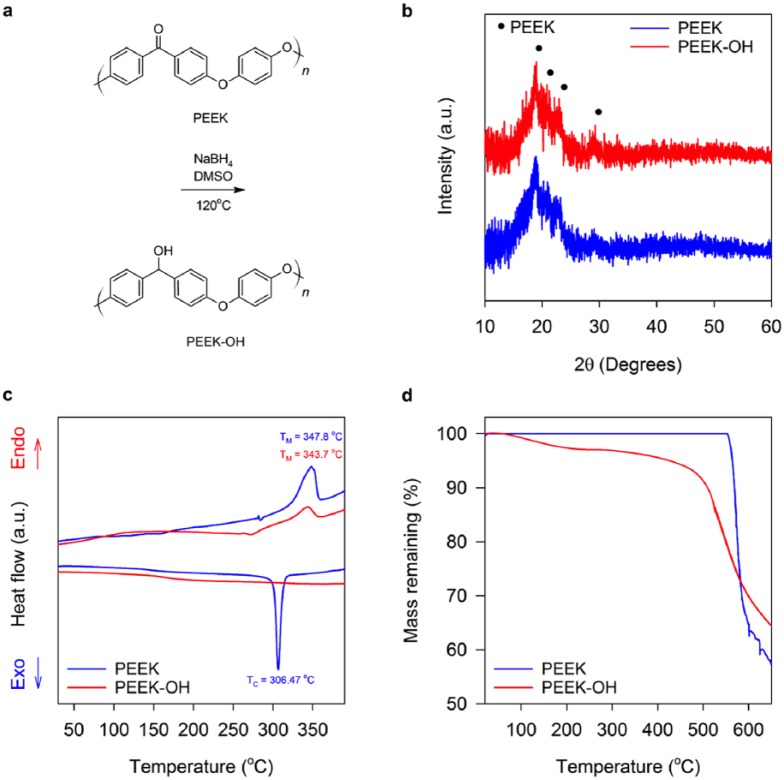
Reduction of PEEK to PEEK-OH with NaBH4. (a) PEEK to PEEK-OH reduction reaction. PEEK and PEEK-OH (b) XRD patterns, (c) DSC traces and (d) TGA traces.